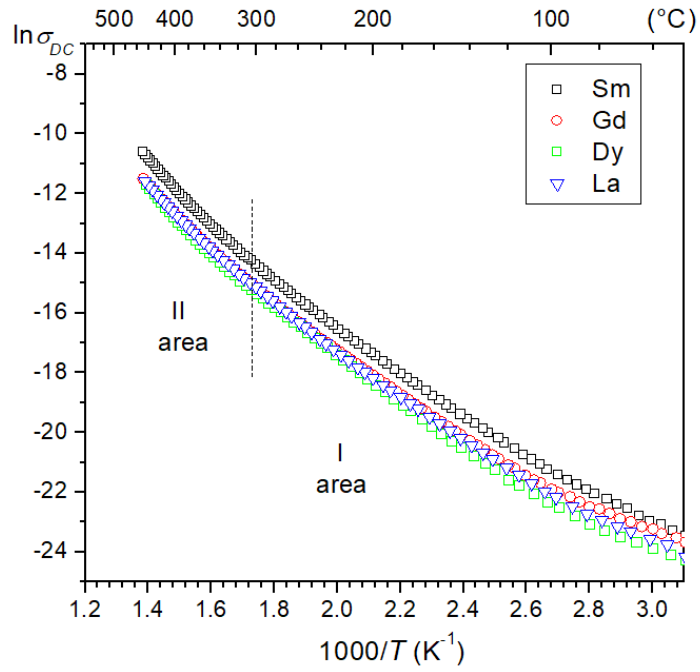
σ (1000 / T ) relationship for the four multicomponent PZT-type Figure 10. The ln  (1000/ T ) relationship for the four multicomponent PZT-type materials. Figure 10. The ln